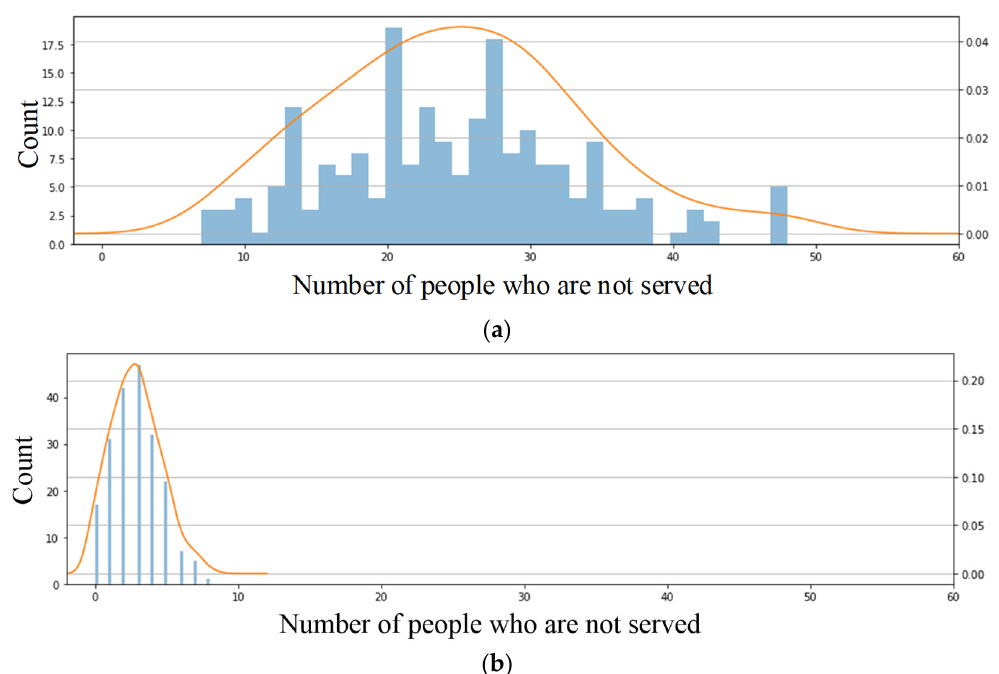
Figure 14. Distribution diagram of number of people who are not served: ( a ) historical records, ( b ) Arena simulation results. The vertical ticks on the left and right are the repetition of days and the probability of appearance at given number of people who are not served.